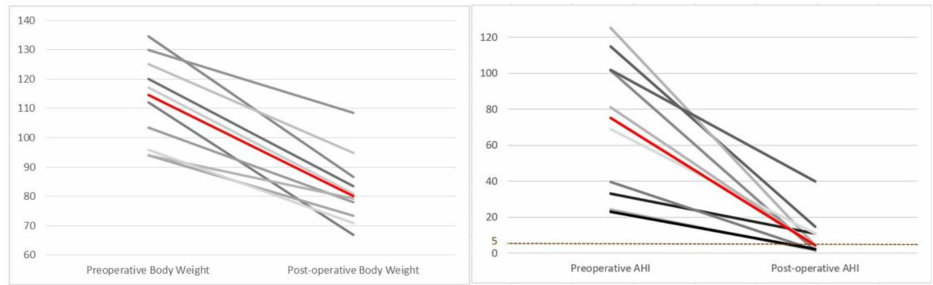
Figure 6. Perioperative changes in body weight and apnea–hypopnea index (AHI) in individual patients (CABS group). Red line: line of median